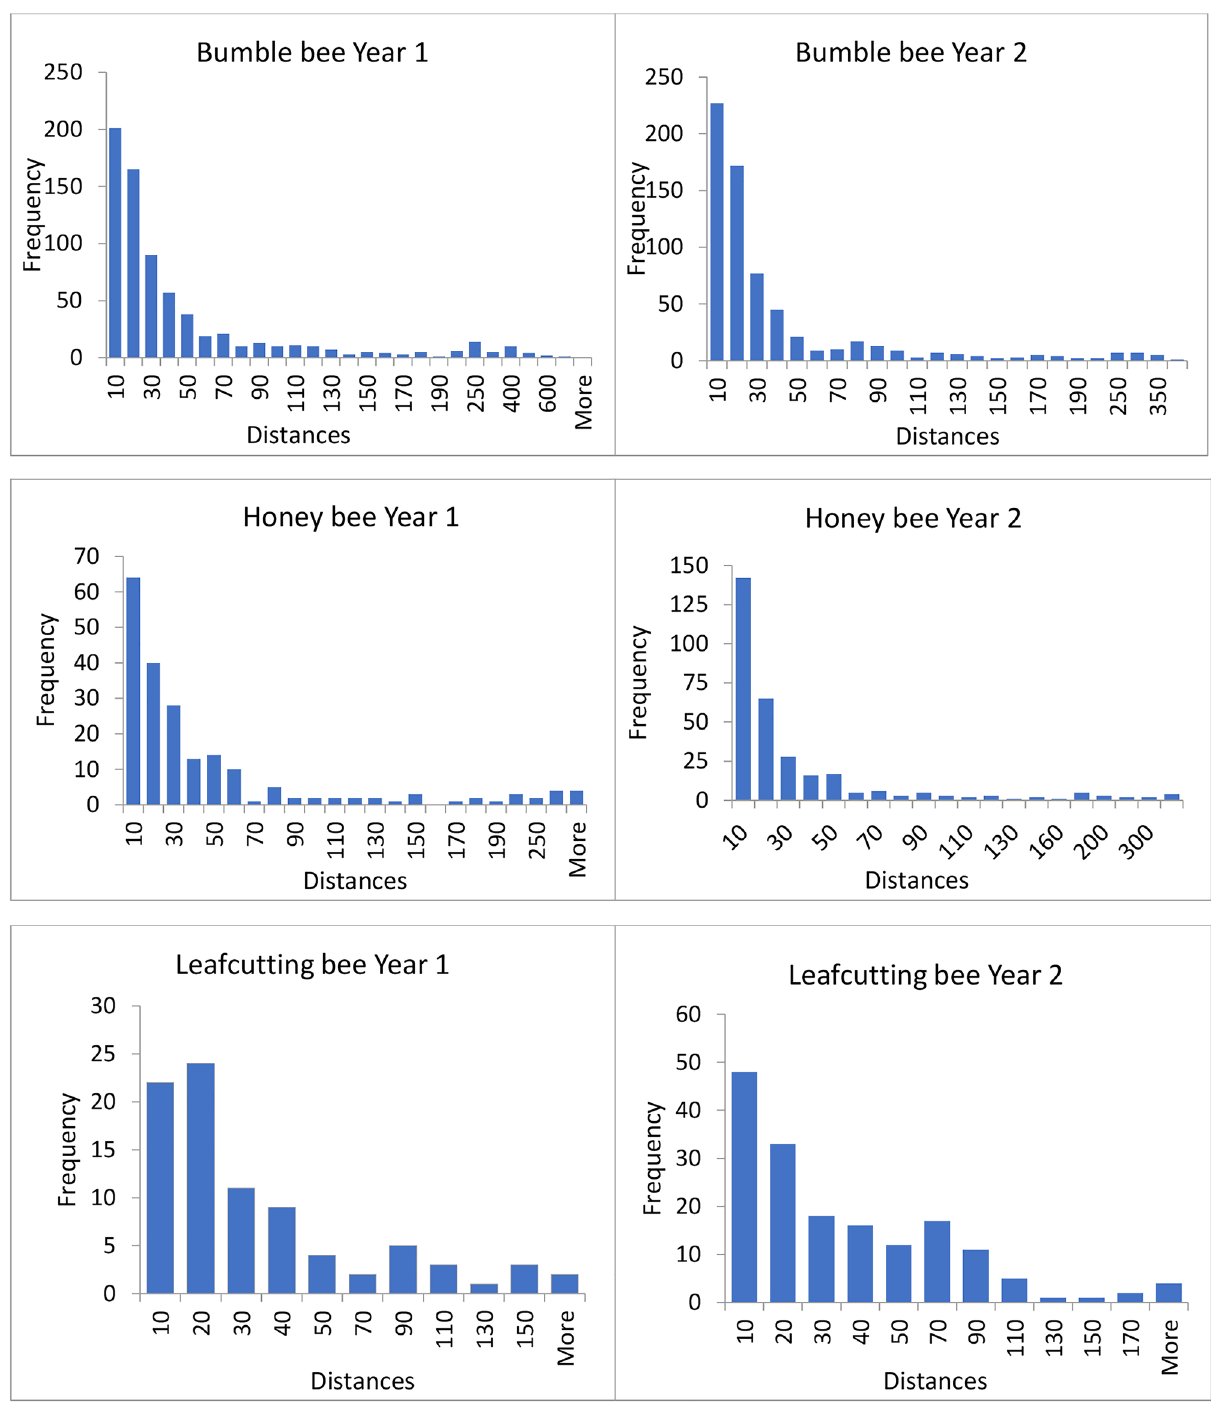
Figure 1. Frequency distributions for distances traveled between consecutive racemes (cm) for each bee species each